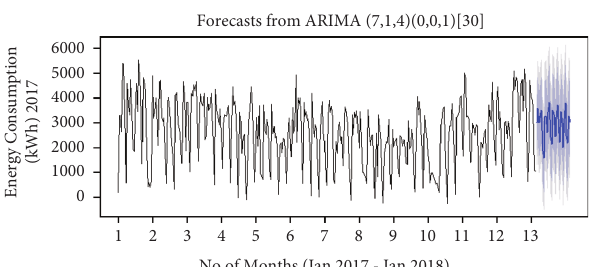
Figure 17: Diagram showing forecasting of energy consumption of January 2018 based on 2017 energy data by using seasonal ARIMA (7,1,4) (0,0,0) order [30].